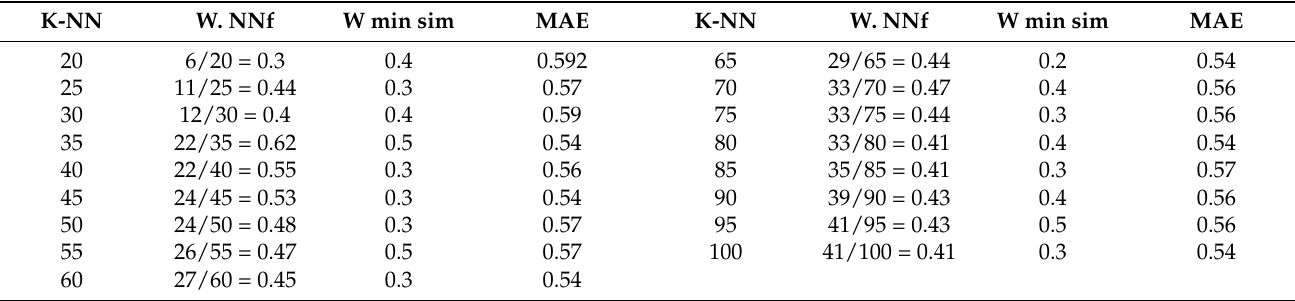
Figure 4. MAE for different K-NN sizes of ML-20M using UGSM and other models. The x -axis is the K-NN size and the Y -axis is the MAE value. Table 8. MAE, NNf, and w min sim of adaptive ML-20M